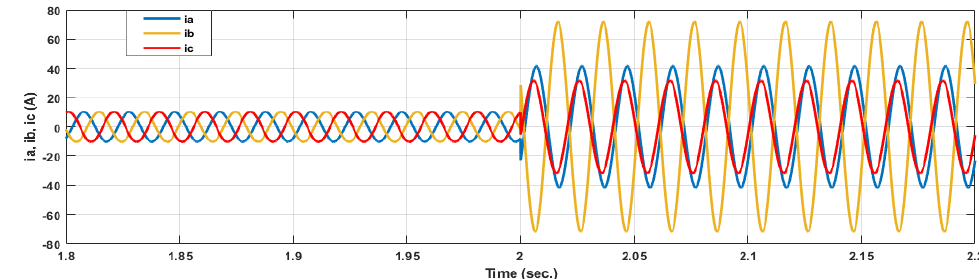
Figure 31. Current signals for 25% short circuit fault in phase b.